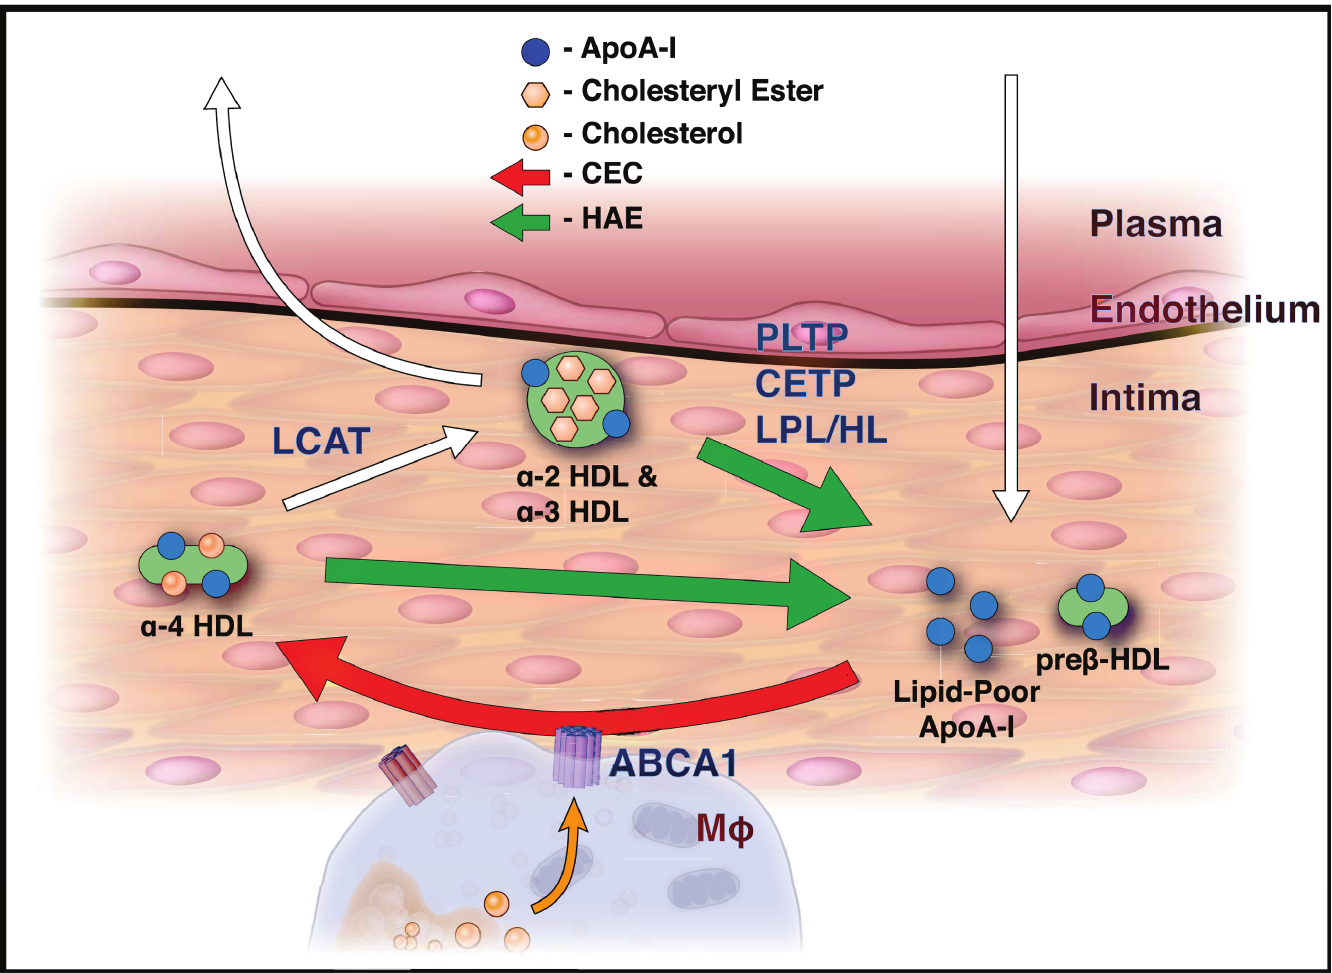
Fig 5. Model of reversecholesterol transport in the arteryintima. White arrows indicatethe movement of HDL particlesinto and out of the intima. Exchangeof apoA-I (green arrows) is measuredby the HAE assay, with the exchangeable pool of HDL coming primarily from the α -particles.This exchangeable pool of apoA-I is the precursor to preß-1 HDL, the primary substrate for de novo HDL biogenesis(red arrow) via ABCA1, residingon cholesterol-loadedmacrophages (M Φ ).